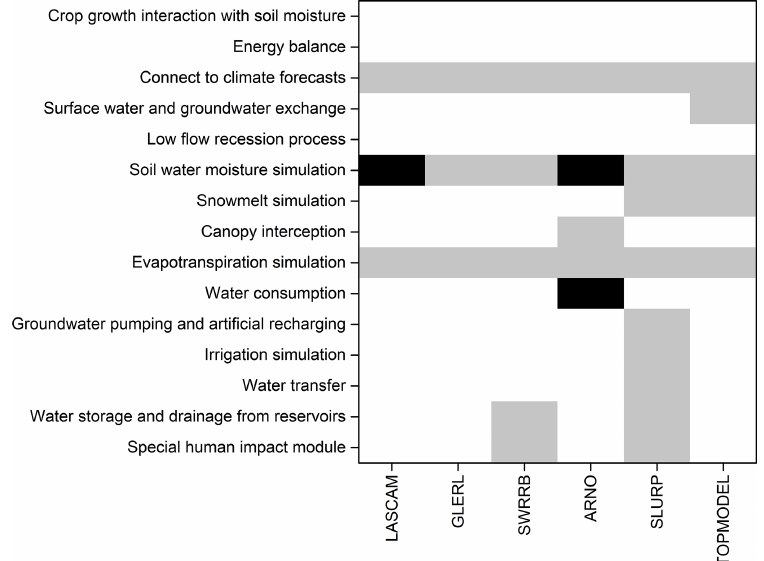
Figure 2. Evaluation of the adaptability of semi-distributed hydrological models for drought forecasting. Where white color stands for grade 0 (no consideration of the function or module); gray color stands for grade 1 (simple simulation of the function or module); black color stands for grade 2 (powerful simulation of the function or module).